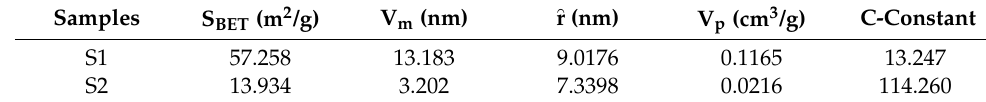
Table 2 . Surface properties of the S1 and S2 samples .